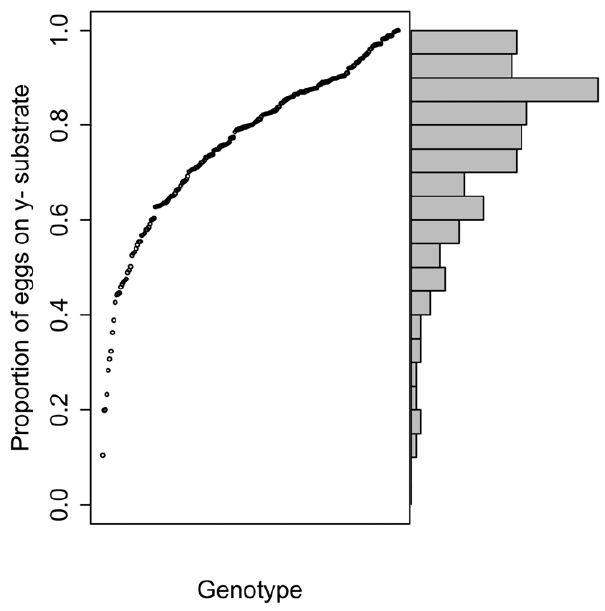
Figure 1. The average proportion of eggs laid on y - media for 213 inbred lines. Variance and sample sizes vary considerably between genotypes (see text), and only means are shown for each genotype, for clarity. On the right, a histogram of the same data is shown. Minimum sample size per line =5 females, mean =11.6 females.